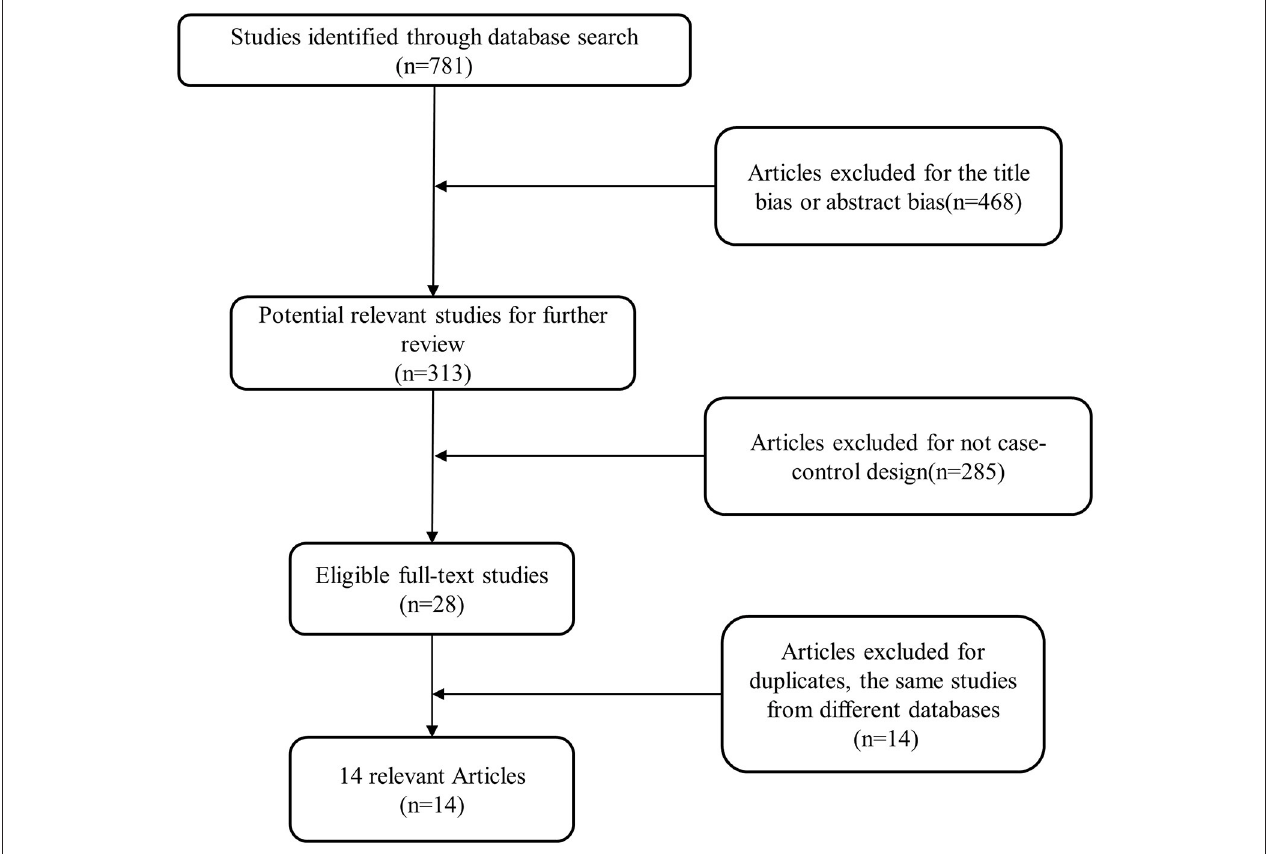
FIGURE 1 | The detailed procedures of study selection in the meta-analysis.